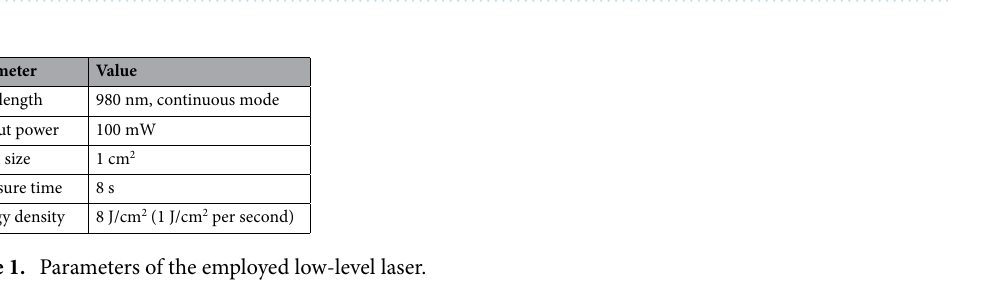
Figure 1. Optical fiber tip held against the maxillary canine root on the experimental side, at a distance of 1.5 cm, as per manufacturer instructions.